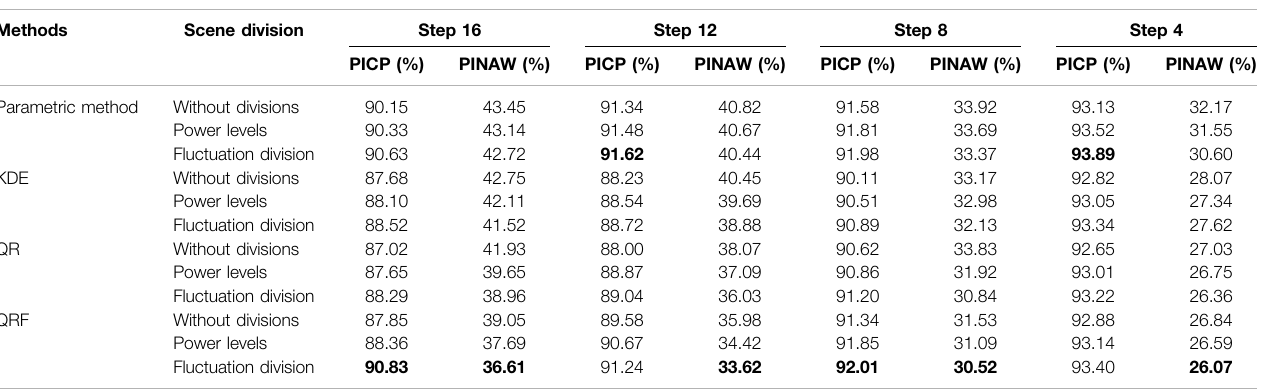
TABLE 4 | Calculation of indicators for different error scenario classi fi cation methods.